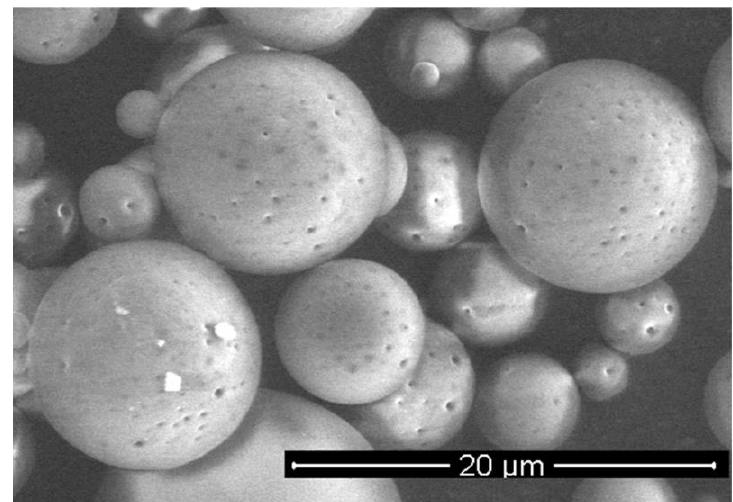
Figure 6. SEM image of SDF-1 α -loaded MS.